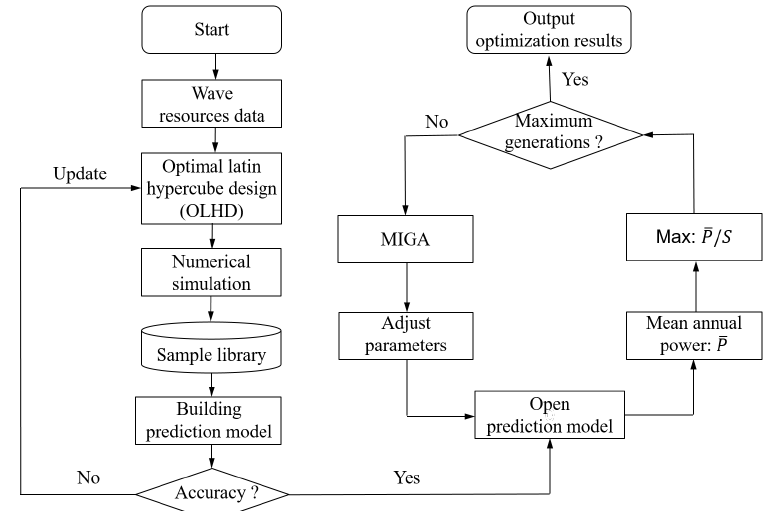
Figure 4. Optimization process.